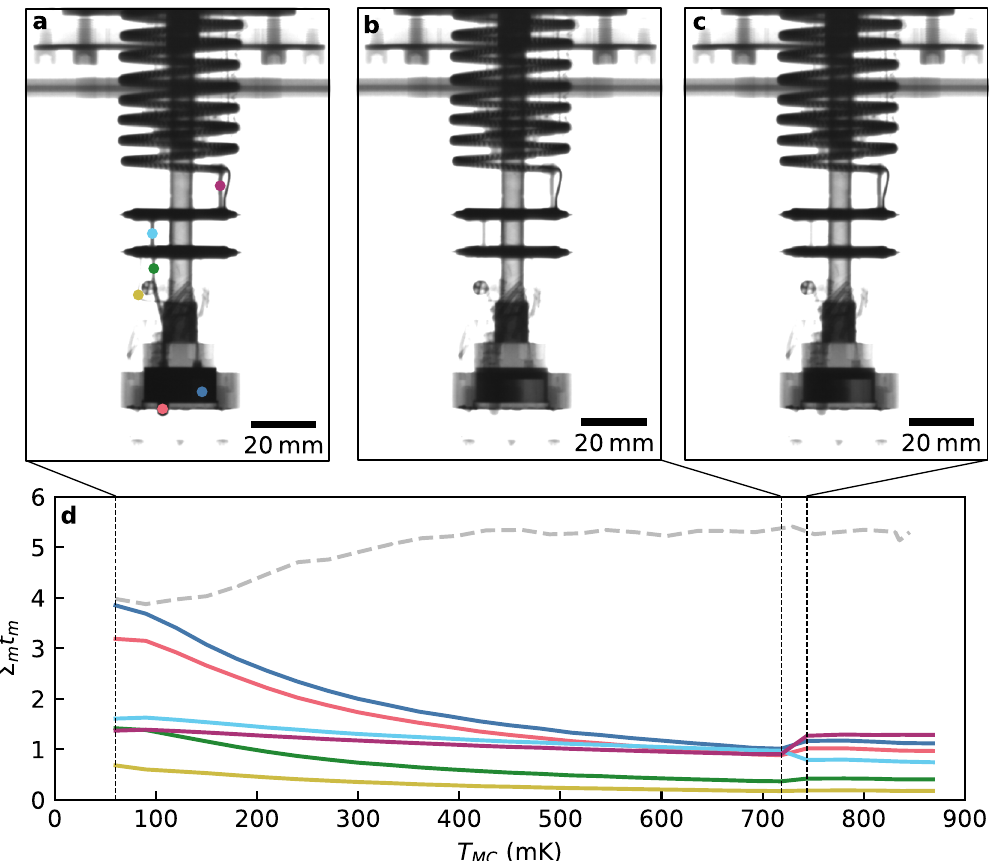
Figure 5. Operation of the dilution refrigerator with insufficient 3 He (28%). Panels ( a – c ) show neutron images of the operating DR, contrast adjusted in order to more clearly show the mixture. Panel ( d ) shows the quantity Σ m t m for neutrons penetrating several parts of the DR, as indicated by the coloured circles in panel ( a ). Note that the neutron absorption in the mixing chamber initially reduces with increasing temperature, the opposite of what would normally be expected (see the dashed grey line, reproduced from the Fig. 3 data), and then changes abruptly around 750